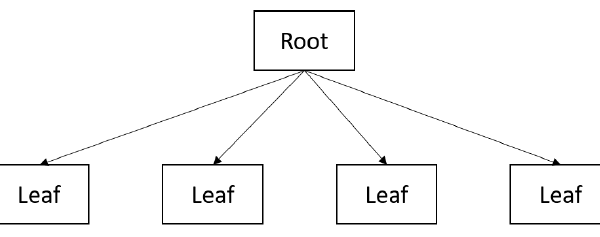
Figure 29. The value NULL indicates that a message was deleted